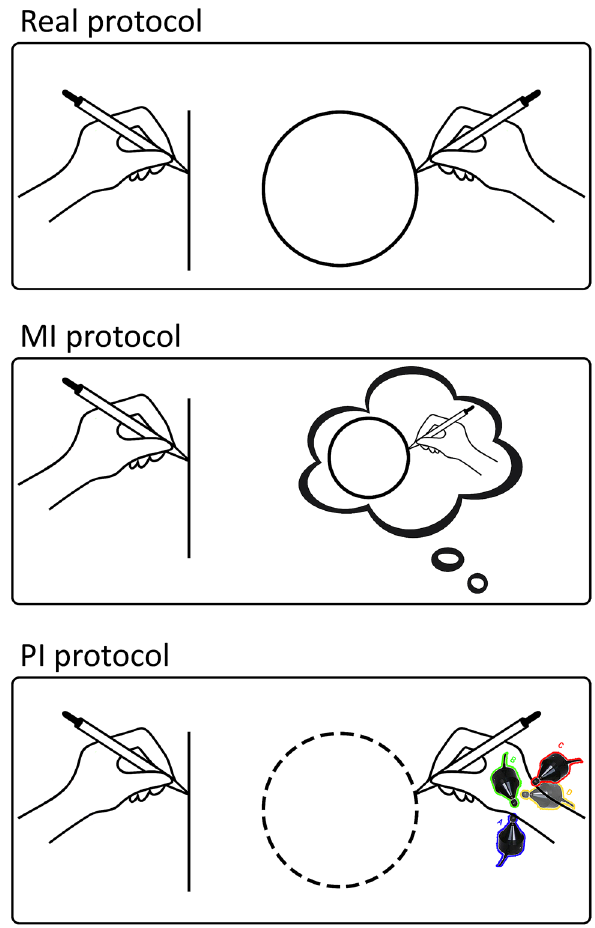
Figure 4. Experimental paradigm. Images show a rapresentative Line-incongruent condition in the Real, Motor Imagery—MI and Proprioceptive Illusion—PI protocols. The left hand actually performed continuous line drawings. In the Real protocol (top) the subject has to actually perform repetitive drawings of circles. In the MI protocol (middle) the subject has to kinaesthetically imagine to perform repetitive drawings of circles. In the PI protocol (bottom) four stimulator were orientated to stimulate 4 tendons of the subject’s wrist. The dotted line represent the stimulation pattern of repetitive circles. Figure were created with Adobe Photoshop (version CC 2015. https:// www. adobe.